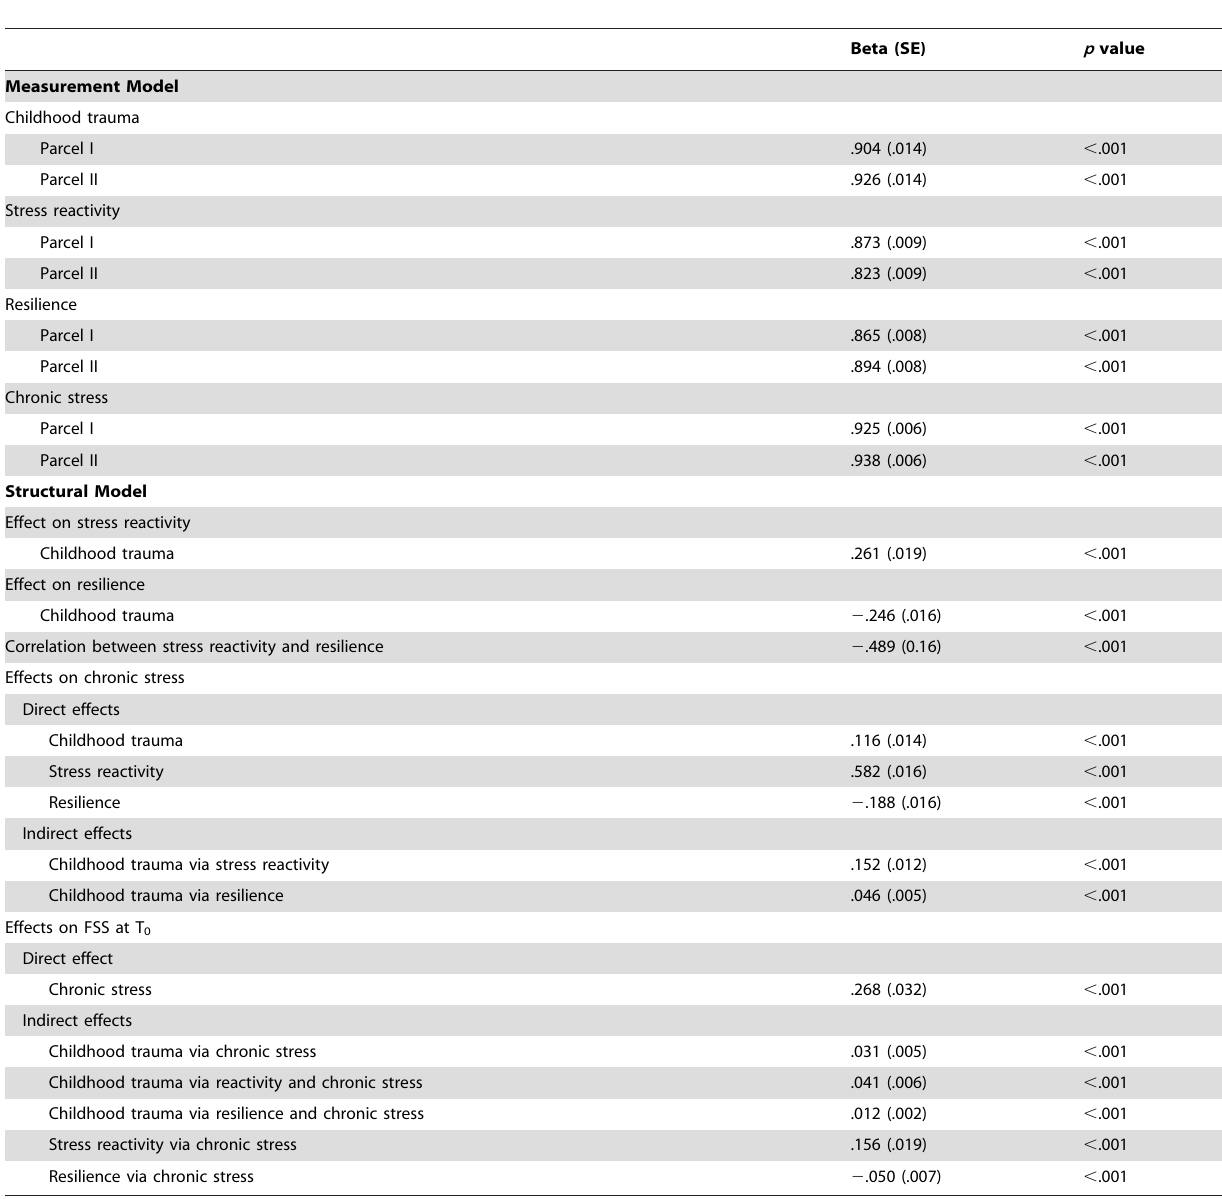
Table 1. Cross-sectional model direct and indirect effects (standardized coefficients) of variables on chronic stress and FSS (T 0 ).